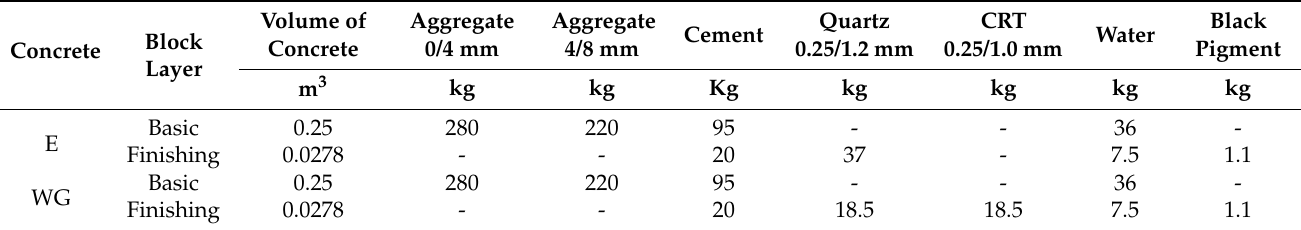
Table 4. Composition of concrete mixtures.